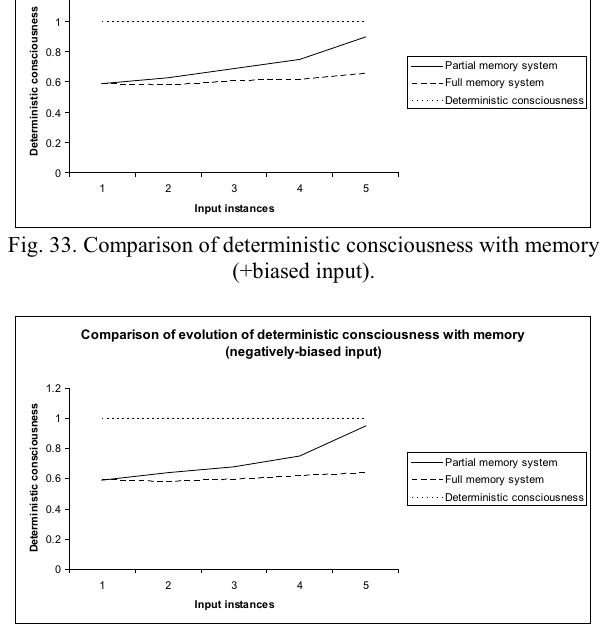
Fig. 34. Comparison of deterministic consciousness with memory ( (cid:16) biased input).